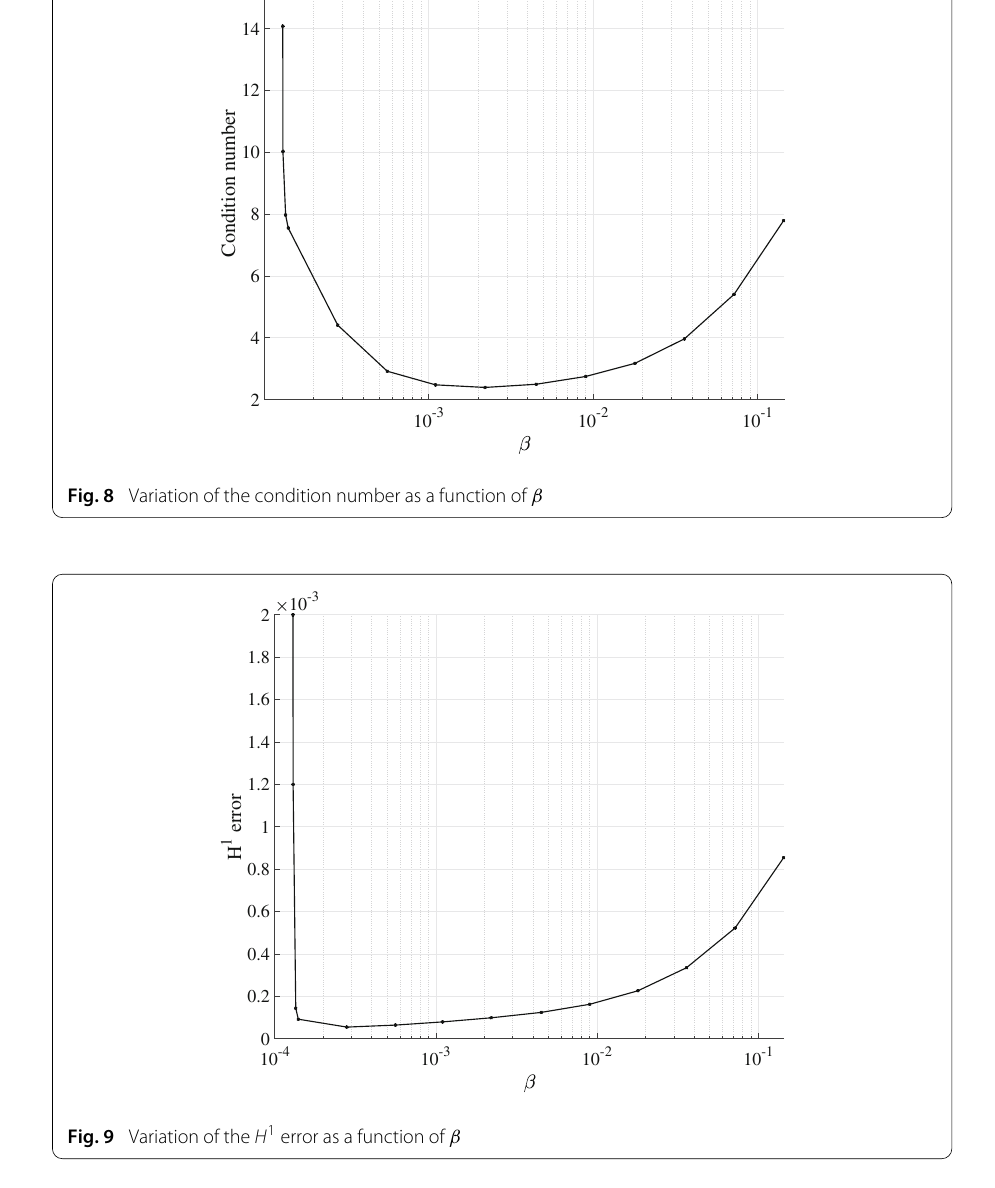
crucial. With our method, the simple rectangular C 1 element has greatly increased its practical